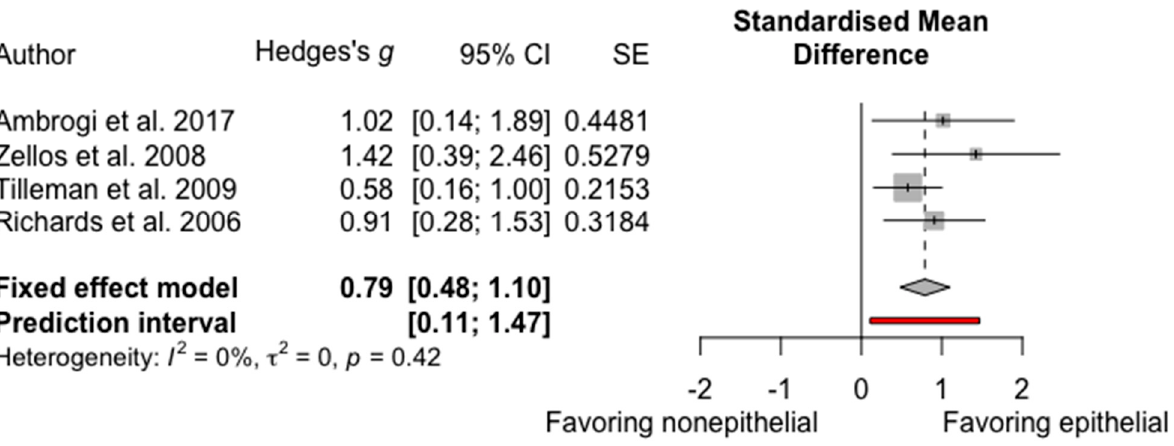
Figure 2. Forest plot of HITHOC vs. no HITOC. The survival effect of HITHOC in epithelioid MPM vs. non-epithelioid MPM was type and 20 with non-epithelioid. Ambrogi et al. [12] reported 43 epithelioid and 6 non-epithelioid tumors. Zellos et al. [10] included 24 epithelioid types and 5 non-epithelioid types. Tilleman et al. [7] had 53 patients with epithelioid, 36 with biphasic, and 5 with sarco- matoid histology. All studies reported an improved survival in epithelioid MPM compared to non-epithelioid MPM. Pooled analysis showed an SMD of 0.79 (95% CI = 0.48–1.10), favoring epithelioid MPM, as shown in Figure 3. As per Cohen et al. [25], an SMD of 0.79 can be interpreted as a borderline “large” effect. Heterogeneity was negligible I 2 = 0%, p = 0.42.